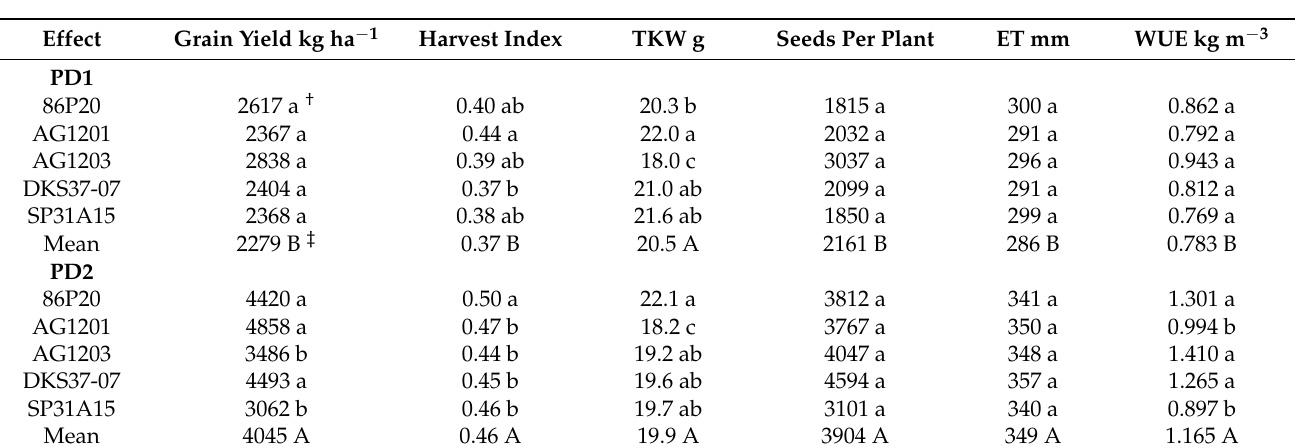
Table 3. Means of grain yield, harvest index, thousand kernel weight (TKW), seeds per plant, evapotranspiration (ET), and water use efficiency (WUE) across 2017 and 2018 as affected by planting